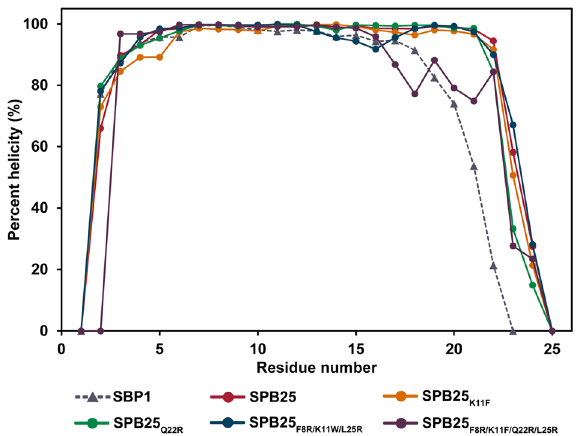
Figure 5. The percent helicities in water of SBP1 36 , SPB25 36 and designed peptides with predicted binding affinities to SARS-CoV-2-RBD better than or similar to